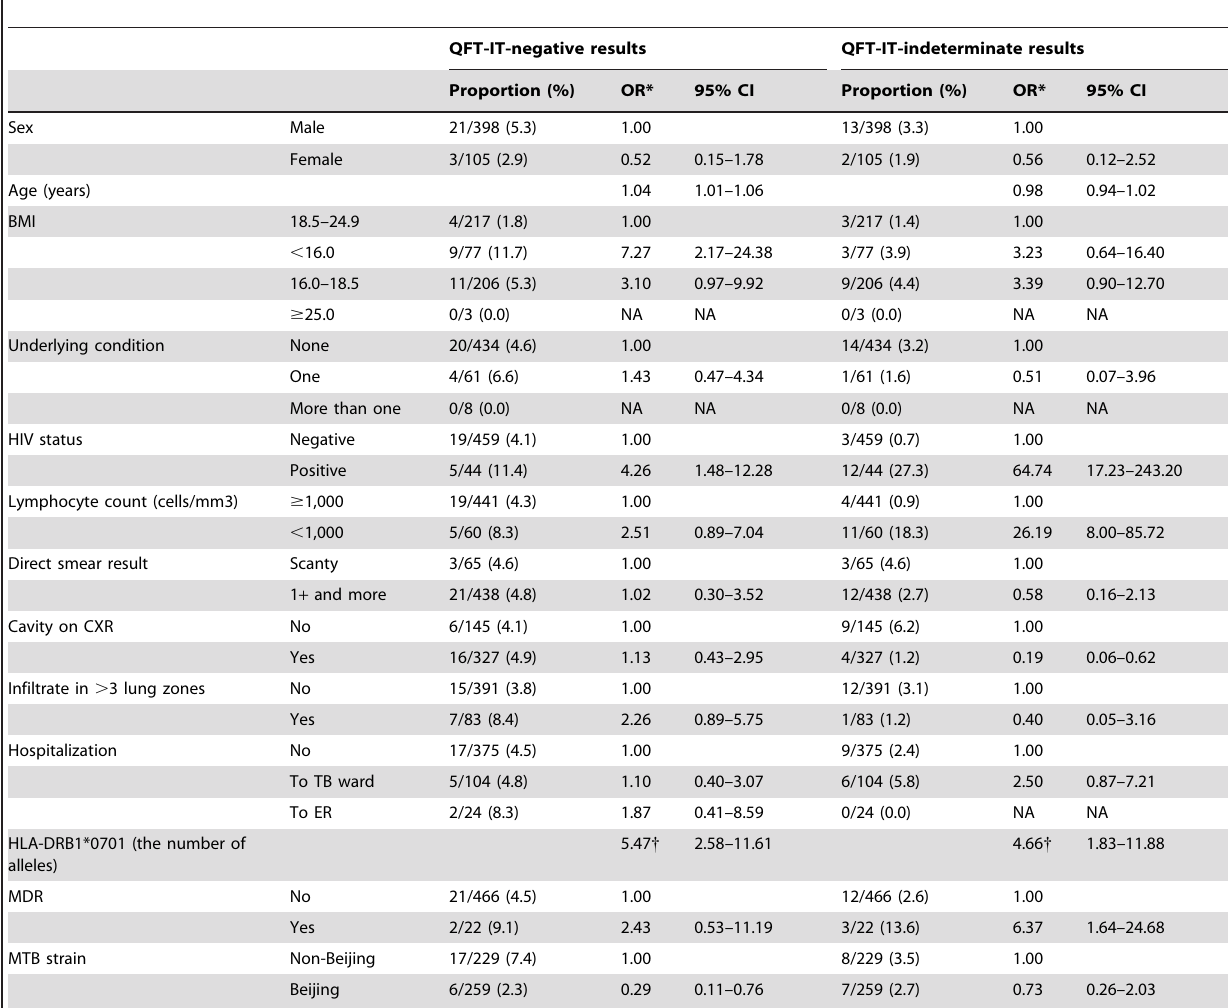
Table 4. Univariate analysis using polytomous logistic regression model for factors associated with QFT-IT-negative and - indeterminate results